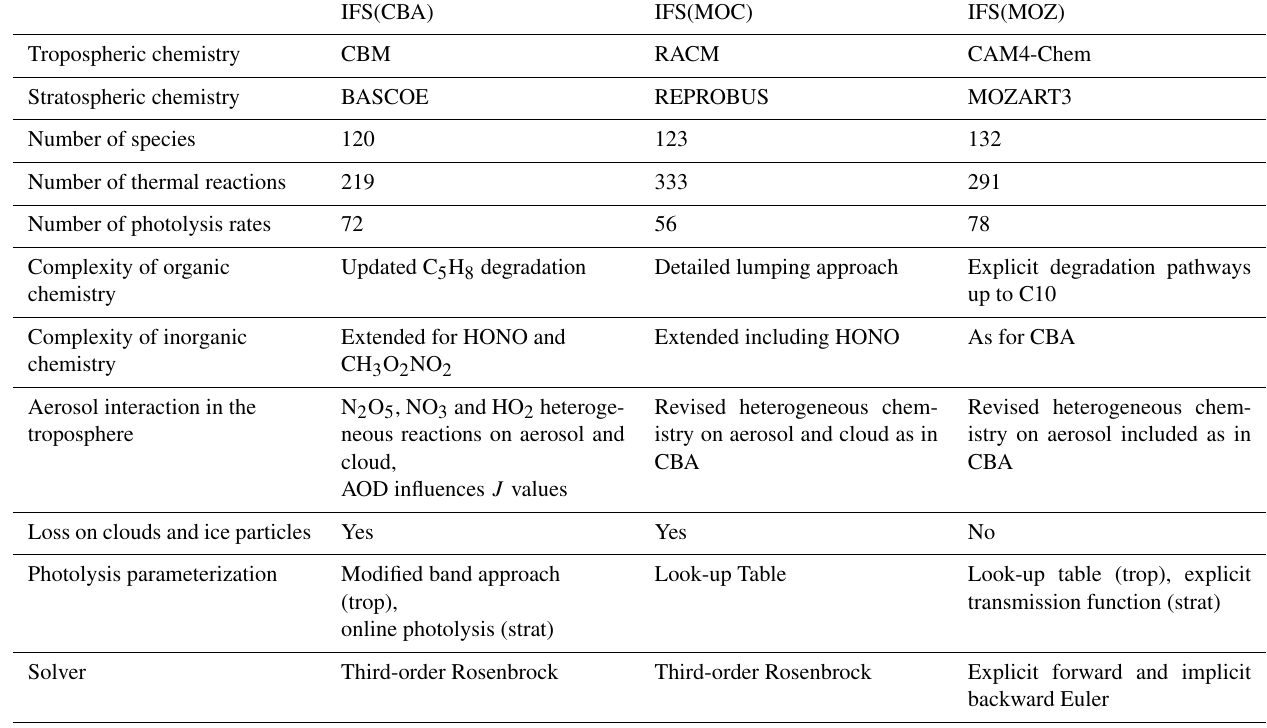
Table 1. An overview of the three chemistry modules included in the IFS for this study with main updates compared to Huijnen et al.